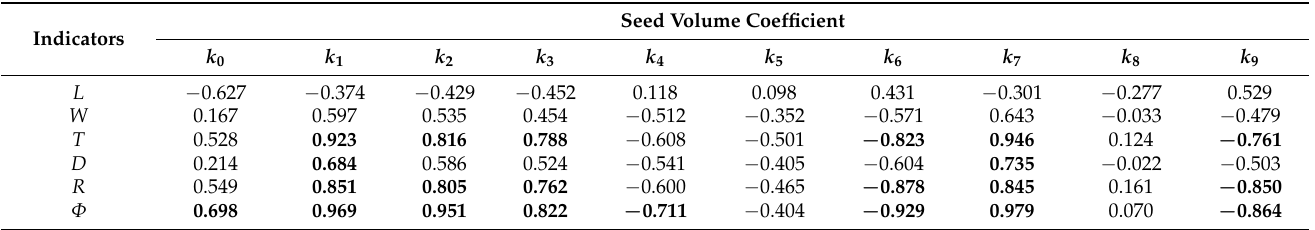
Table 4. Correlations between seed volume coefficients vs. dimensions and indicators describing seed